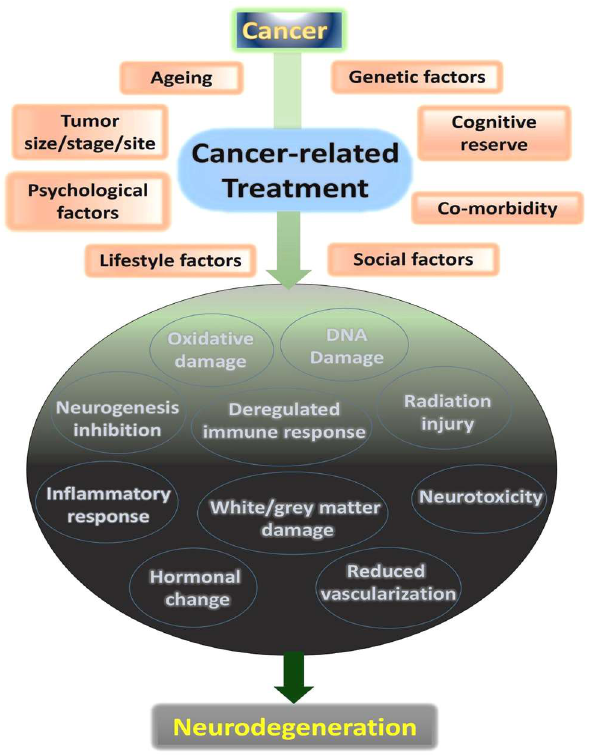
Figure 1. Risk factors and mechanisms of neurodegeneration from cancer treatment.